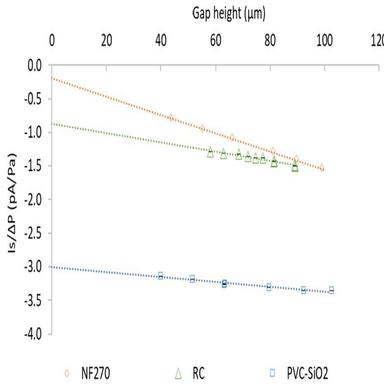
Streaming current coefficient (Is/ΔP) of the unmodified NF270, RC and PVC-SiO2 membranes versus gap height; Solution: 0.001 M KCl at pH 5.60 ± 0.05.